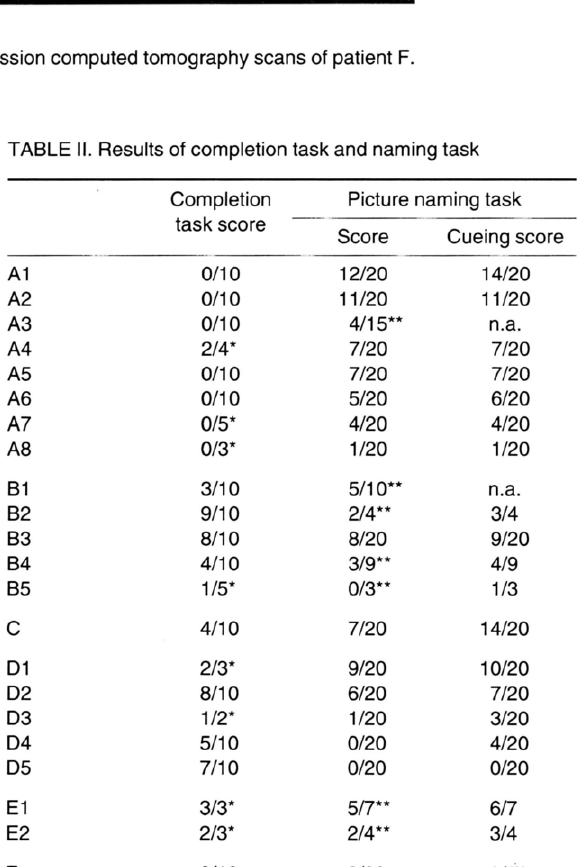
FIG. 4. Three-dimensional surface single photon emission computed tomography scans of patient F.